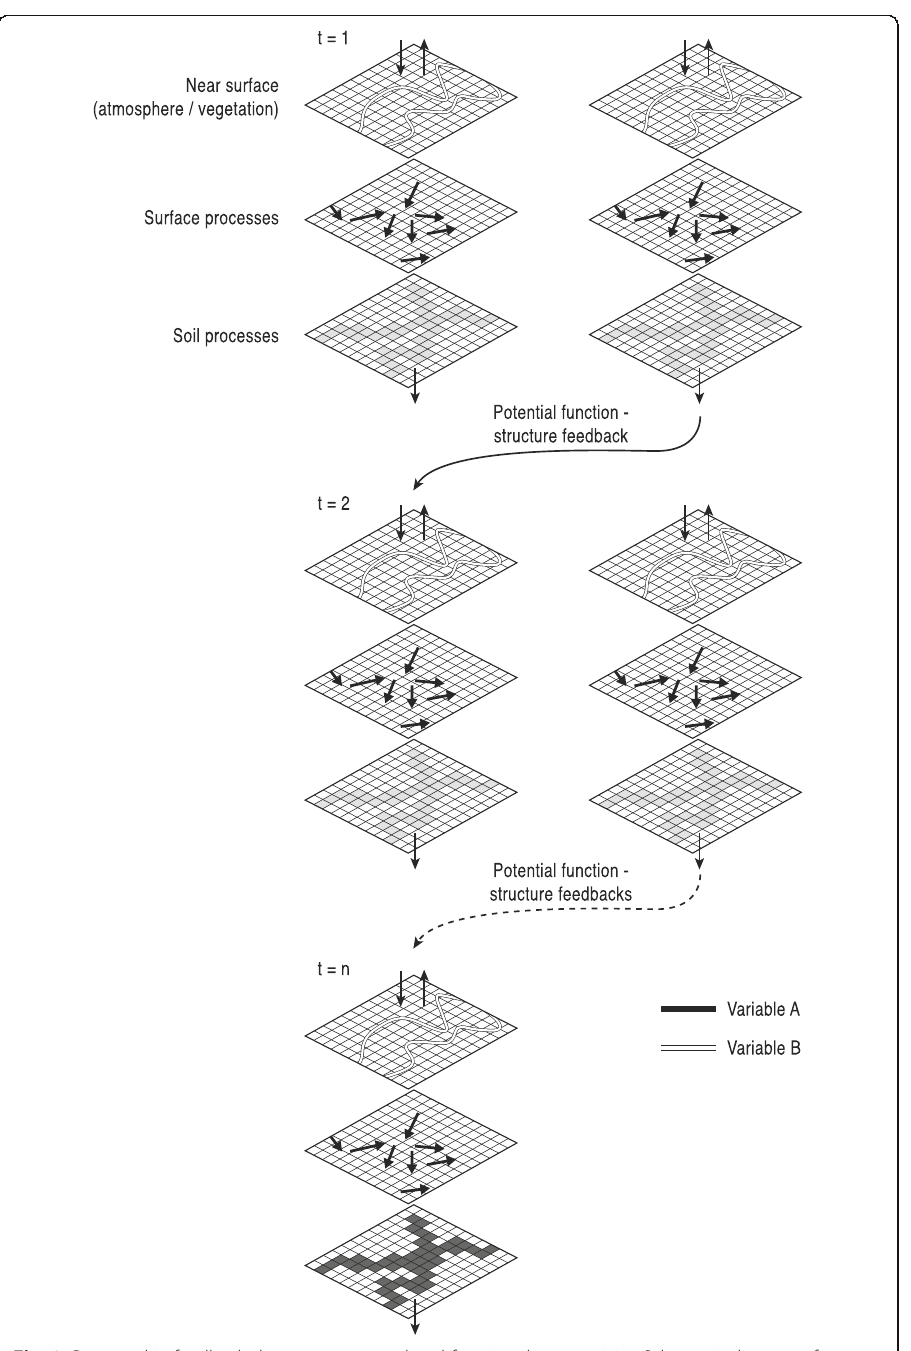
Fig. 3 Geomorphic feedbacks between structural and functional connectivity. Schematic diagram of feedbacks between structural and functional connectivity (source: Wainwright et al., 2011). The relative locations of values of different variables which control SC may initially (t = 1) be quite discrete, leading to functional disconnections which are only connected during events of specific types or magnitudes, which in turn can create structural feedbacks by reorganizing landscape elements (e.g. vegetation, soil types). Through time (t = 2, … , n), these feedbacks may be reinforced so that structural and functional connectivity follow similar patterns, and the system become difficult to reverse (see Turnbull et al.,